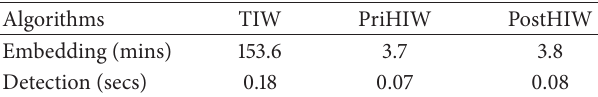
Table 2: Computation time for the embedding and detection